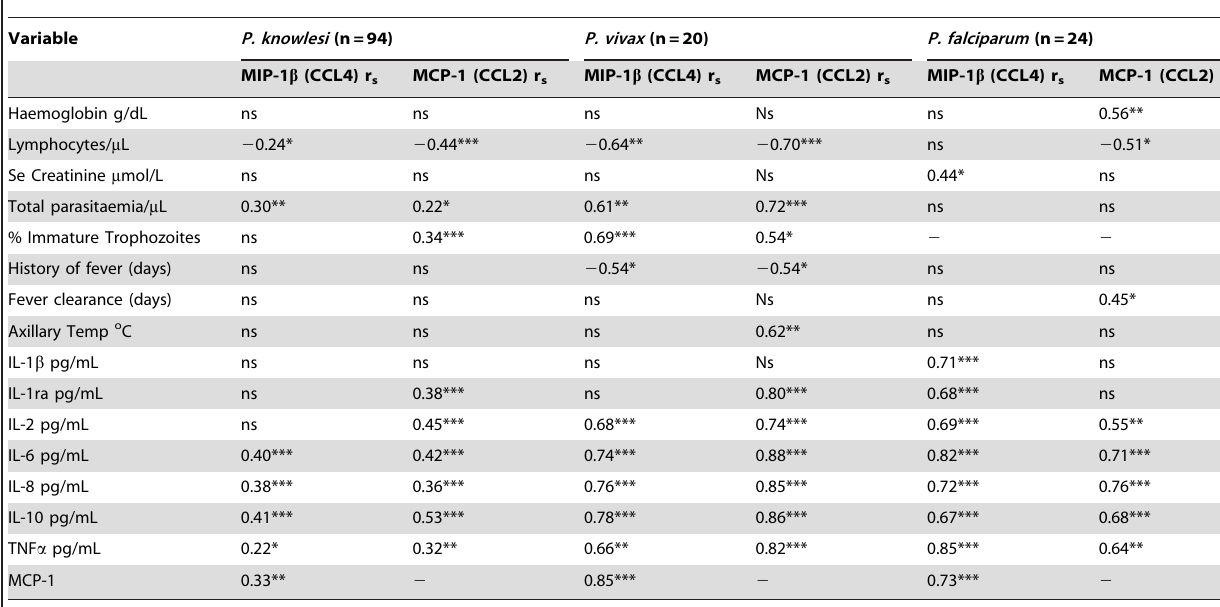
Table 4. Correlates of macrophage and monocyte